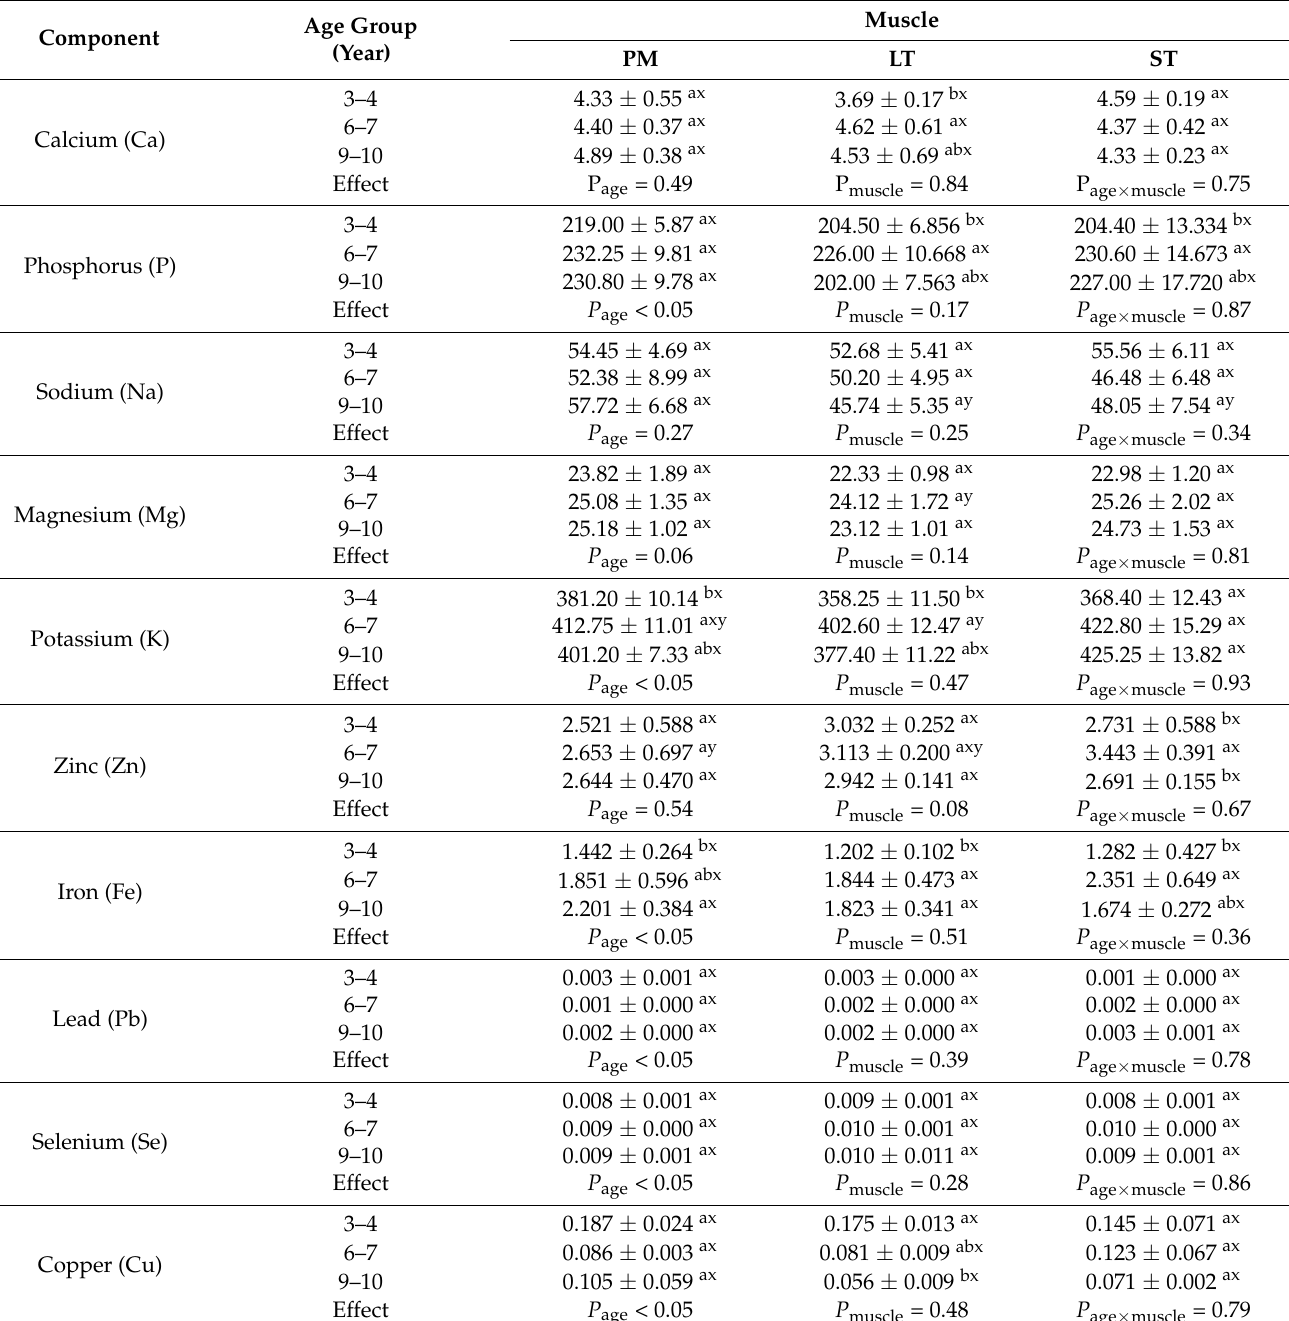
Table 3. Macro and micro-element levels (mg/100 g) in the Longissimus thoracic (LT), Semitendinosus (ST), and Psoas major (PM) muscle samples from Alxa Bactrian camels ( n = 5, mean ± standard error) slaughtered at three different